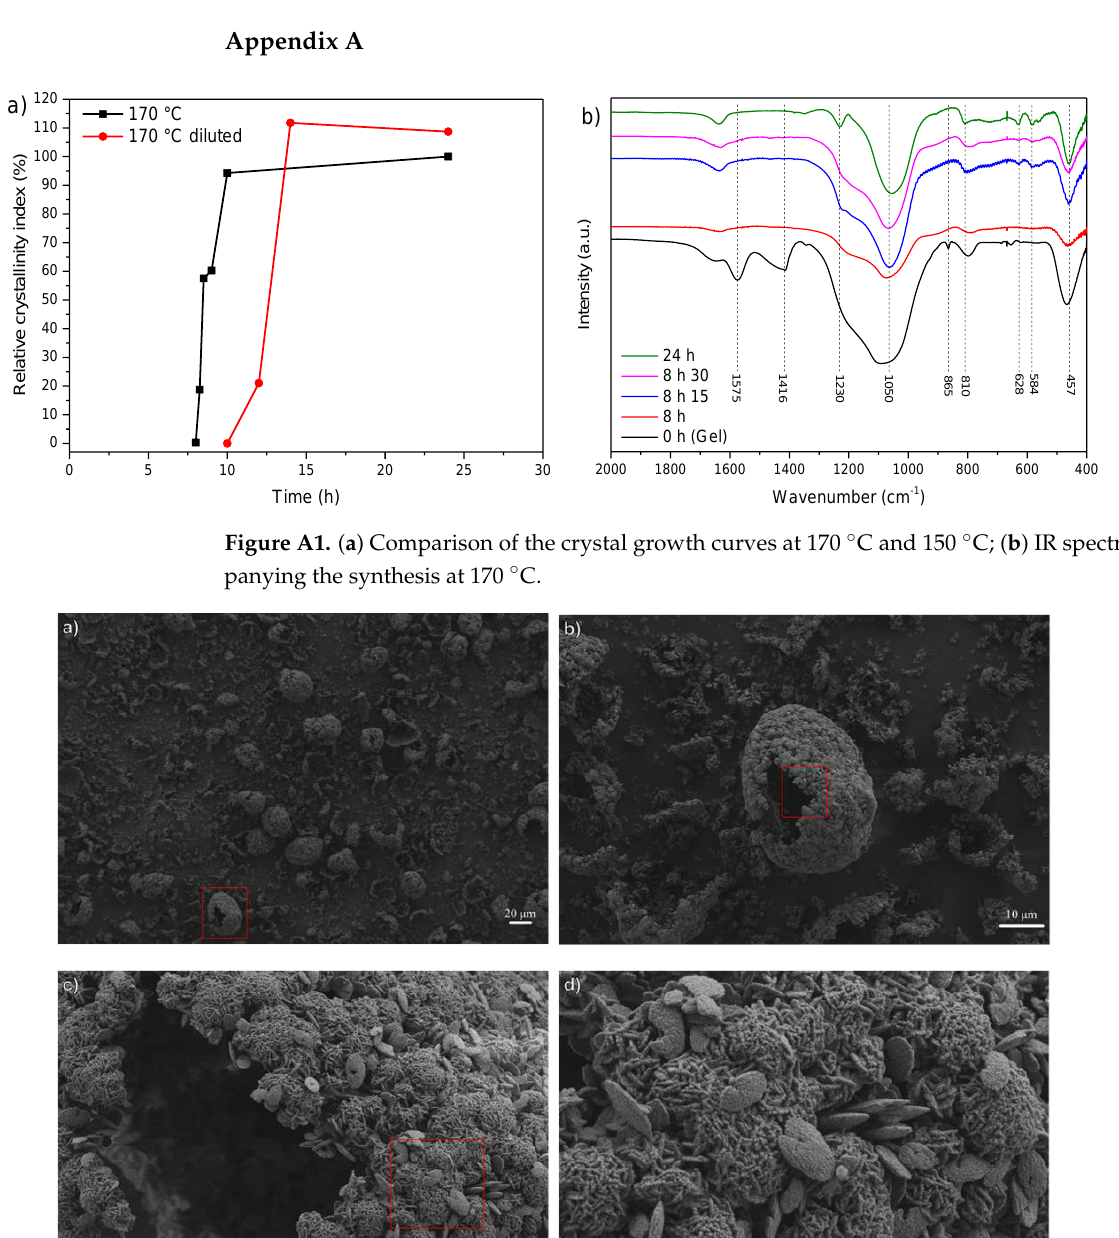
Figure A3. Comparative crystal growth curves for diluted and nondiluted sample series at 170 °C ( a ) and 150 °C ( b ). Figure A4. SEM images showing that the agglomerate of the diluted gel sample obtained at 170 °C do not aggregate in the spherical shape found in other samples ( a ) and the particles present smaller aggregation compared to the nondiluted samples ( b ). 0